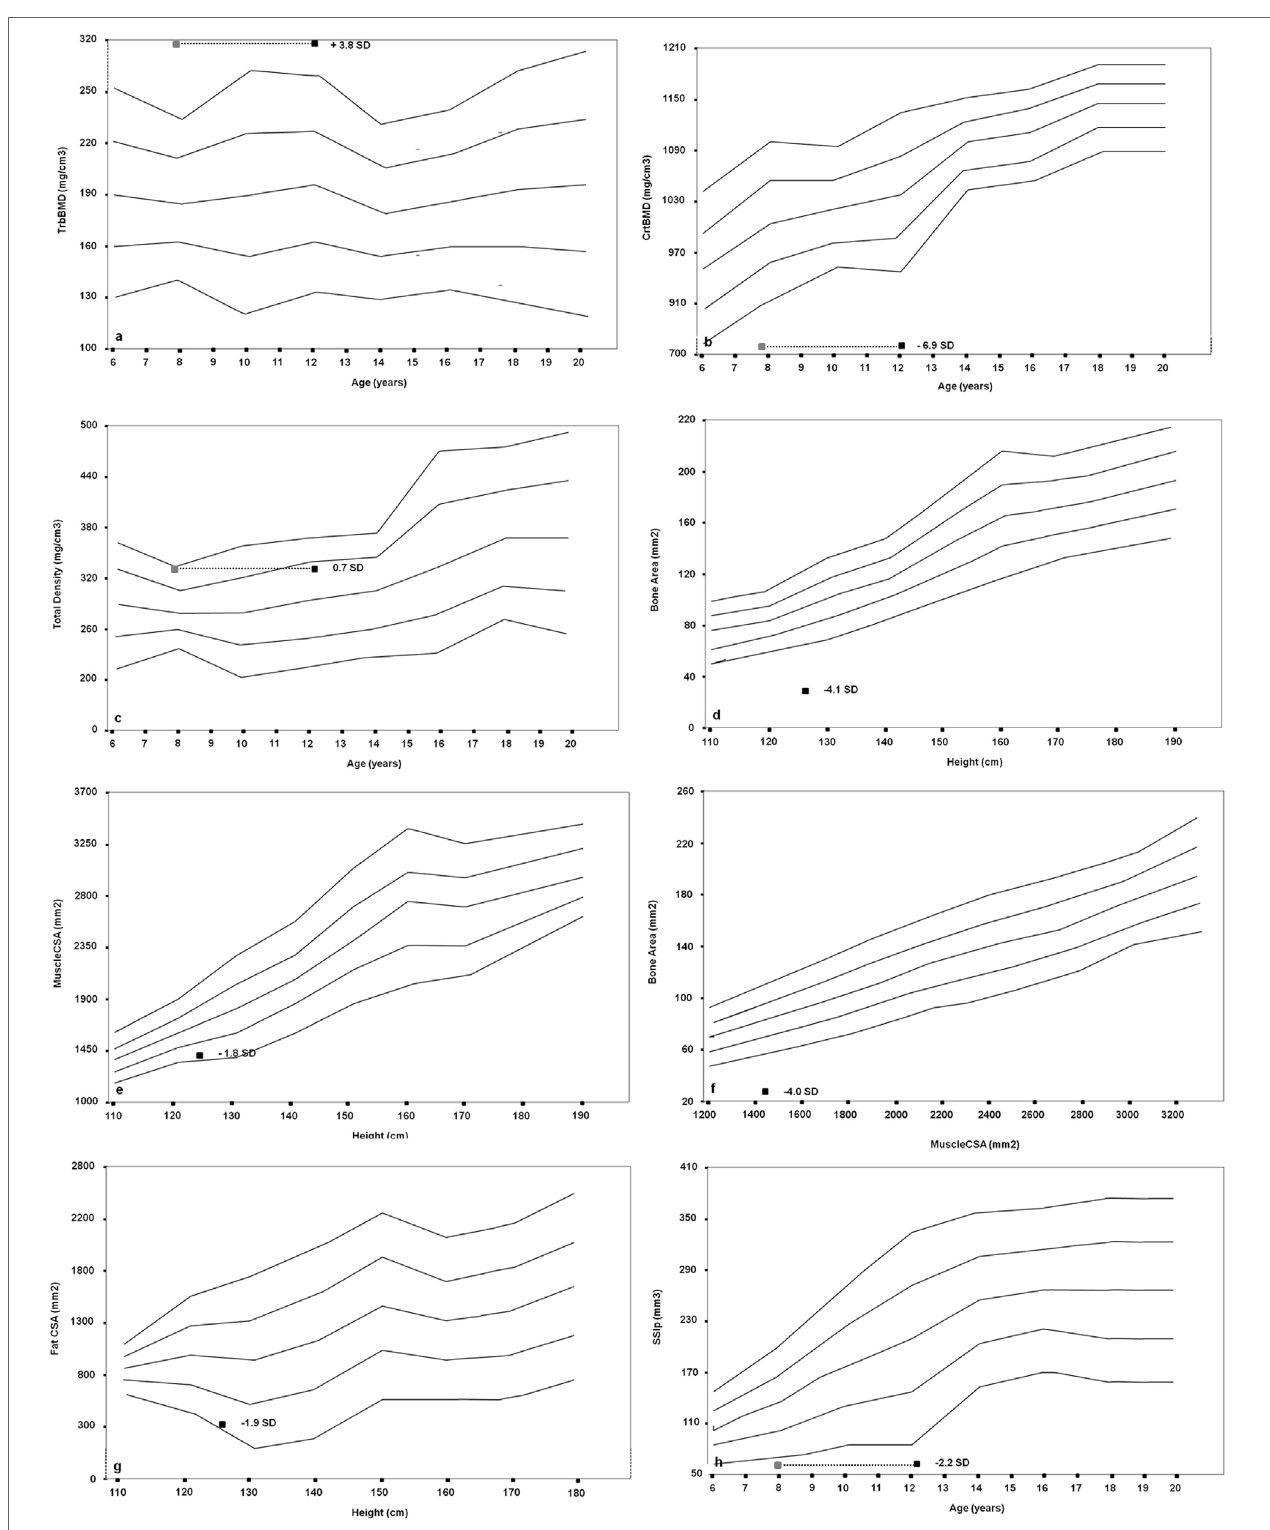
FIGURe 3 | Cross-sectional evaluation of trabecular bone mineral density (TrabBMD) (a) , cortical bone mineral density (CrtBMD) (B) , total density corrected for age (C) , bone area corrected for height (D) , muscle cross-sectional area (MuscleCSA) corrected for height (e) , bone area corrected for MuscleCSA (F) , fat cross-sectional area (FatCSA) corrected for height (G) , and density-weighted polar section modulus (SSIp) (h) . The gray squares in the panels (a,B,C,h) represent the bone age-adjusted